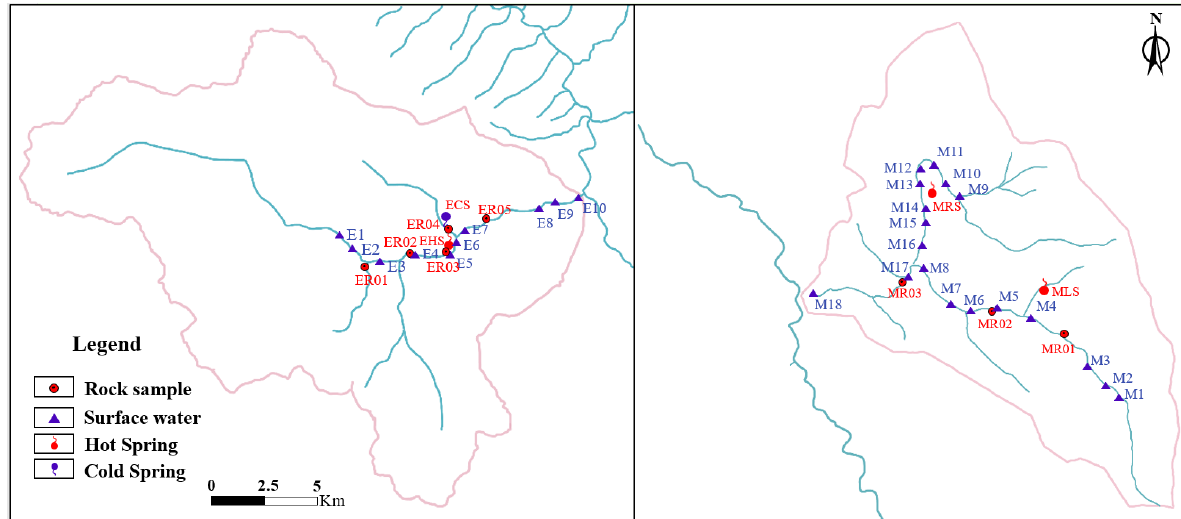
Figure 2. Distribution of samples in Endaqu tributary ( left ) Mangdaqu tributary ( right ).